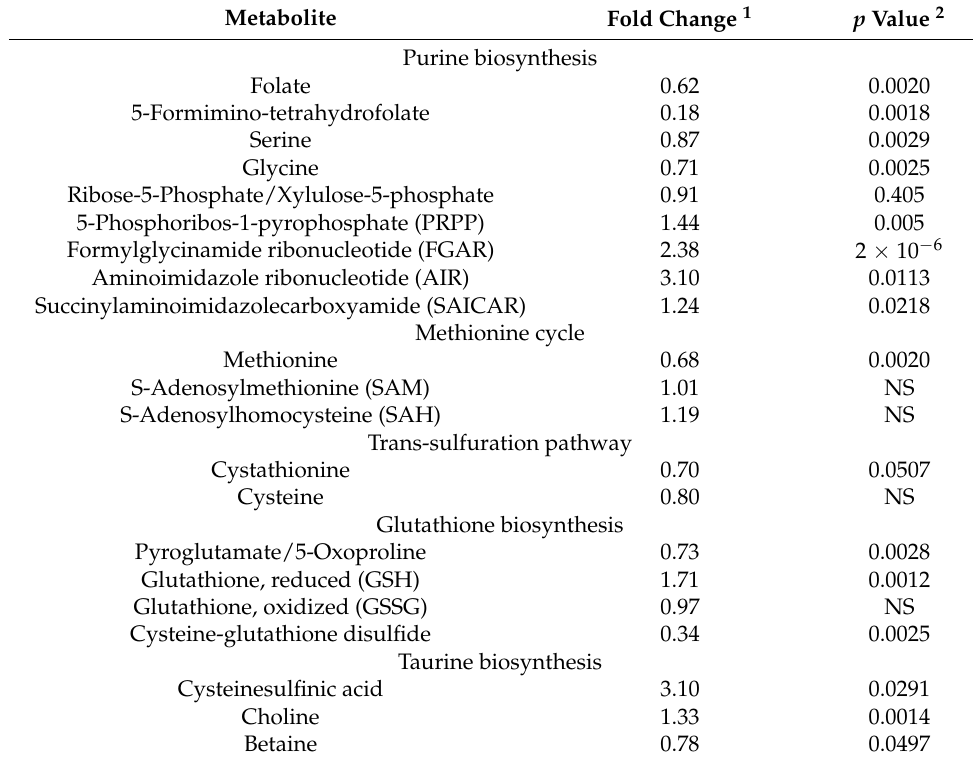
Table 1. Intracellular metabolites affected by the SARS-CoV-2 infection of Vero E6 cells. Metabolite Fold Change